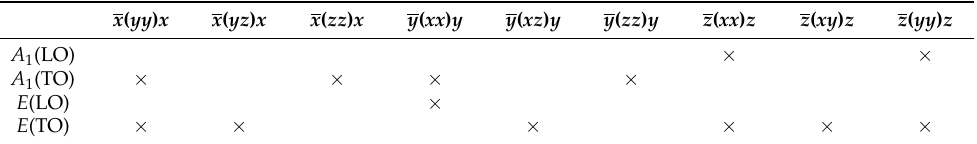
Table 4. The POLARIZATION SELECTION RULES [32–34] at the BCS for the Raman spectra of the (GaN) m /(AlN) n SL family with even m + n in the backscattering geometry. In tables, “ × ” represents the modes that can be observed in each one of the directions. In the first row, the experimental configuration in Porto’s notation is